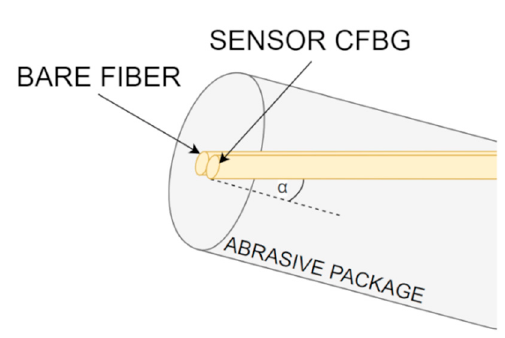
Figure 12. Abrasion sensor packaging together with Fresnel reflection reference, allowing for Figure12. AbrasionsensorpackagingtogetherwithFresnelreflectionreference, allowingforminimizing minimizing the unwanted Fresnel reflection from the end of the sensor grating. the unwanted Fresnel reflection from the end of the sensor